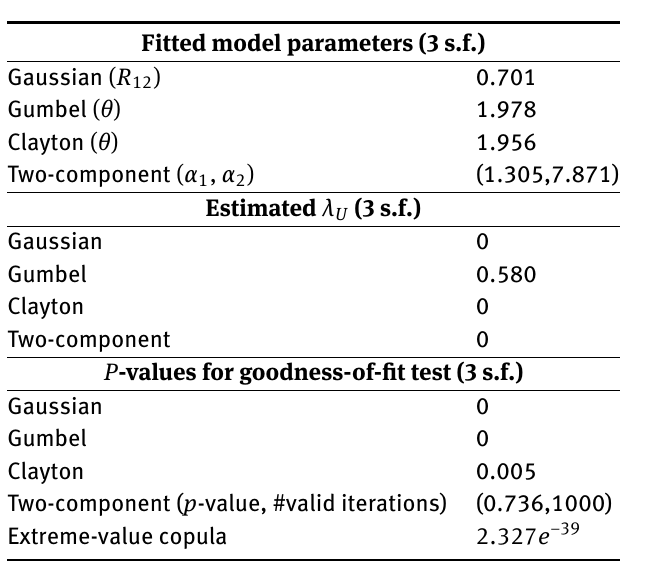
Table 3.1: Results table for fitting copulas to data simulated from the Two-component model with α 1 = 1.320427 and α 2 = 5.478712 , σ 1 = 1, σ 2 = 0.9 . The p -values are given before the generalised Benjamini-Hochberg procedure.